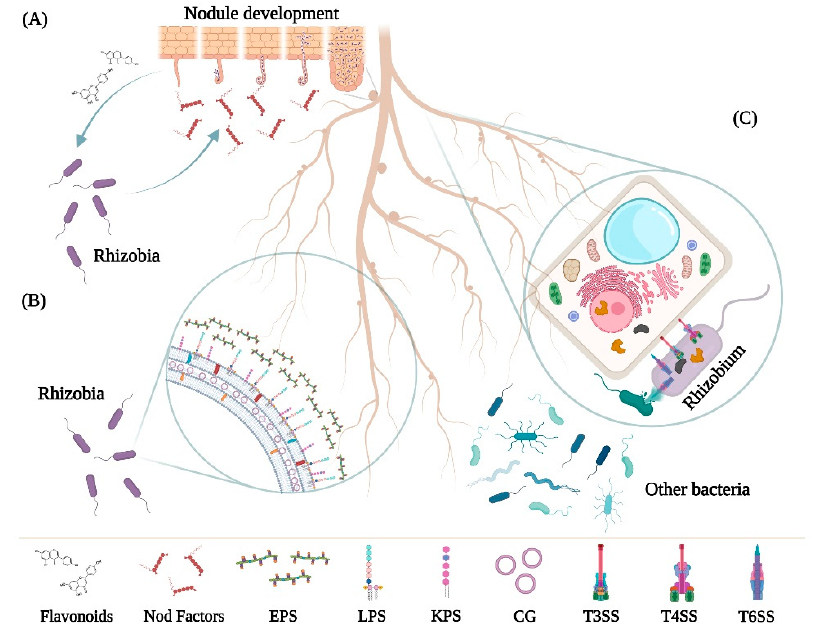
Figure 1. General checkpoints in rhizobia–legumes symbiosis. ( A ) Specificity in nod factor and flavonoid production and detection during rhizobial colonization, infection, and invasion throughout the nodulation process. ( B ) Rhizobial surface polysaccharides [exopolysaccharides (EPS), lipopolysaccharides (LPS), K-antigen polysaccharides (KPS) and cyclin glucans (CG)] play a role either as signal molecules required for the progression of symbiosis and/or as protective agents against plant defense responses. ( C ) Effectors translocated through the rhizobial type III secretion system (T3SS), type IV secretion system (T4SS) or type VI secretion system (T6SS) can modulate plant defense responses to facilitate bacterial infection of the host. The T6SS can also be used as a killing machine devoted to outcompeting other rhizosphere bacteria.